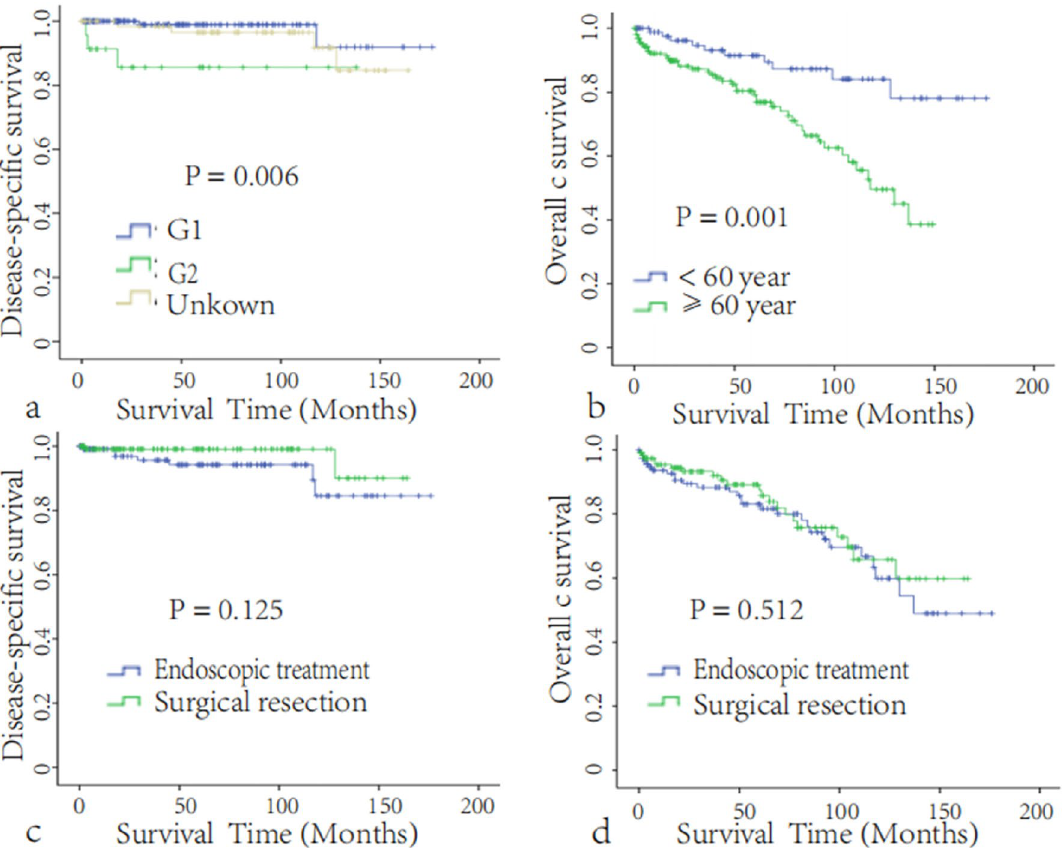
Figure 3. ( a ) Disease-specific survival according to tumor grade after PSM (n = 248). ( b ) Overall survival according to age after PSM (n = 248). Subgroup survival analysis of patients with T2N0M0 disease. Disease- specific survival ( c ) and overall survival ( d ) of the endoscopic treatment group and surgical resection group after PSM (n =